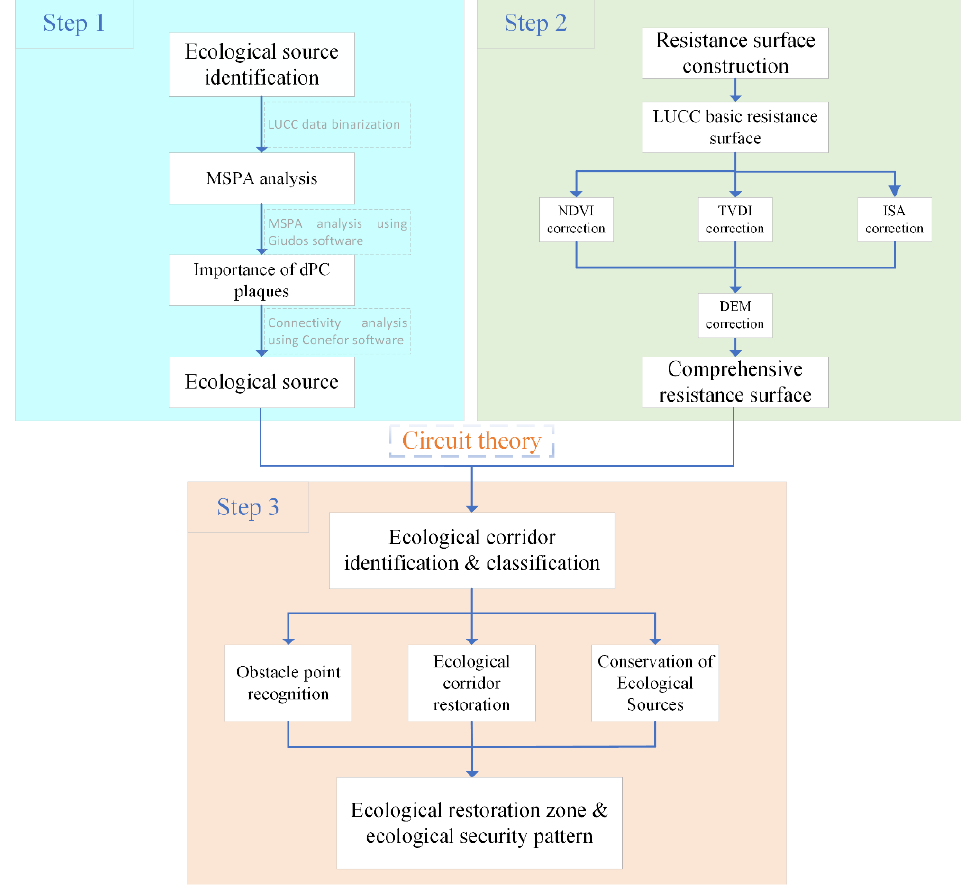
Figure 2. Framework for identifying ESP.